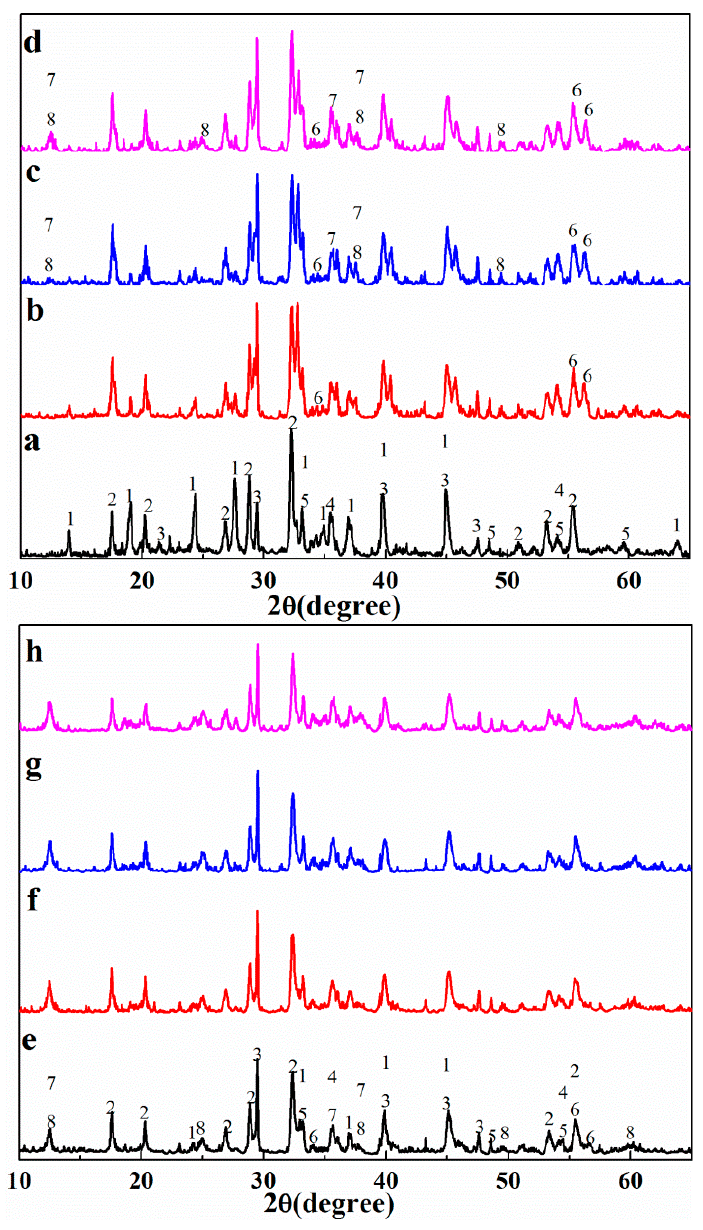
Figure 6. XRD patterns of the solid products at 200 °C: ( a ) Bayer red mud; ( b ) 0% MgO addition; ( c )